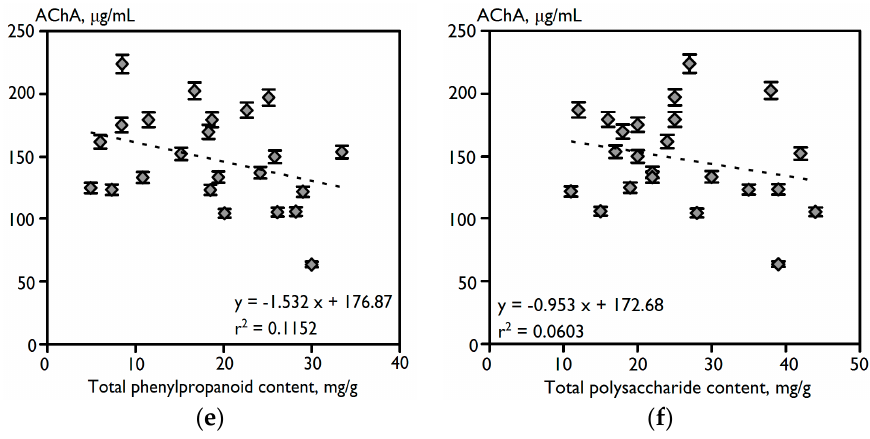
Figure 1. Correlation graphs (dashed lines) between total content of essential oil ( a ), carotenoids ( b ), triterpenoids ( c ), flavonoids ( d ), phenylpropanoids ( e ) and polysaccharides ( f ) (mg/g) in total extracts of flowers of 23 varieties of C. officinalis and their anti-acetylcholinesterase activity value (AChA; IC 50 , µg/mL). Reference compounds: neostigmine (positive control; active, IC 50 = 0.75 ± 0.01 µg/mL), NaCl (negative control; inactive).